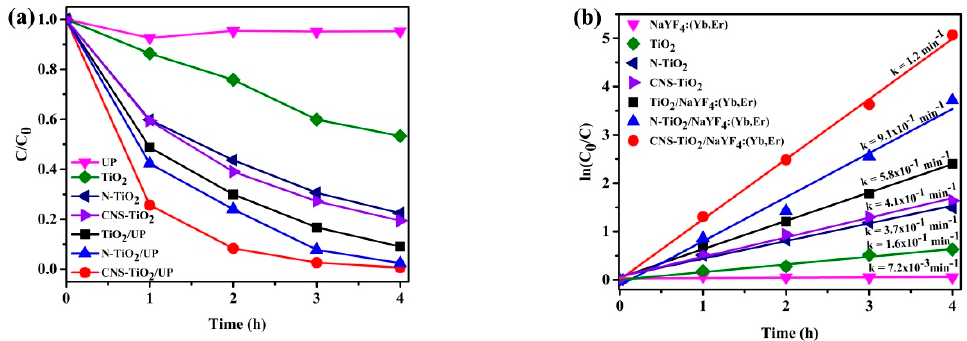
Figure 7. ( a ) MB peak absorbance variation as degraded with 254 nm UV illumination. Here, UP